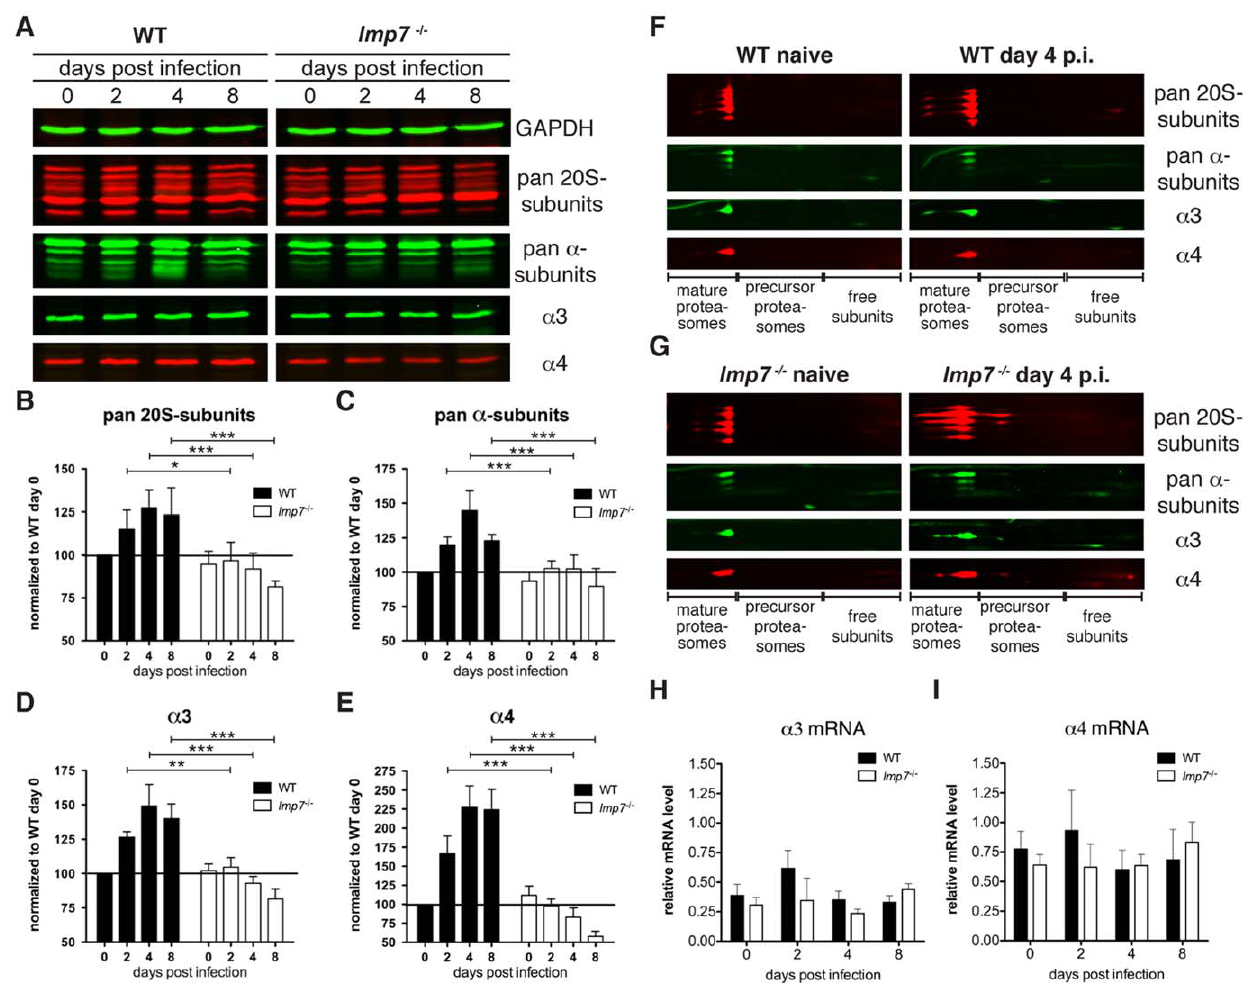
Figure 6. Relative quantification of mature proteasomes in WT and lmp7 2 / 2 mice during the course of listeria infection. WT and lmp7 2 / 2 mice were infected i.v. with 5 6 10 3 cfu of L. monocytogenes and livers of three to four mice per group were pooled for two-colour fluorescent immunoblot analysis. Naı¨ve mice (day 0) were used as controls in both groups of mice. Each membrane was stained against GAPDH as loading control. Further, membranes were stained with antibodies recognizing pan-20S subunits, pan- a -subunits, a 3 and a 4as indicated. Representative blots of three independent experiments are shown (A). Following densitometric analysis the relative protein abundance of pan-20S subunits (B), pan- a - subunits (C), a 3 (D) and a 4E was expressed as band intensities normalized to WT day 0, which was calculated as follows: (band intensity of proteasome subunit X at day Y/band intensity of GAPDH at day Y)/(band intensity of proteasome subunit X in WT day 0/band intensity of GAPDH in WT day 0) 6 100). The given results are means 6 standard deviation of three independent infection experiments and each sample was analysed in duplicates during immunoblot analysis (B–E). To analyse in which proteasome complexes the analysed structural subunits are integrated, 2D two- colour fluorescent immunoblot analysis was performed on liver lysates of naı¨ve and infected WT (F) and lmp7 2 / 2 mice (G). Brackets mark the areas, in which the different proteasome fractions are found. qPCR analysis on total liver cDNA was performed to assess the mRNA expression of a 3 (H) and a 4I during the course of listeria infection in WT and lmp7 2 / 2 mice. The relative mRNA expression of the proteasome subunits was calculated by normalization to the housekeeping gene RPS9 using the DD CT method. Each value represents mean 6 standard deviation of three individual mice.